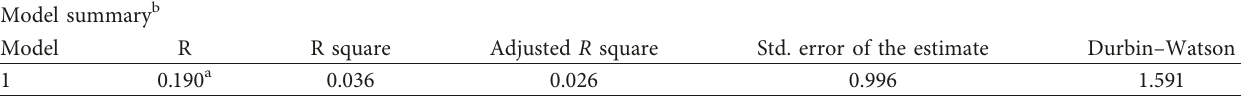
Table 10: Model summary table: urban poverty